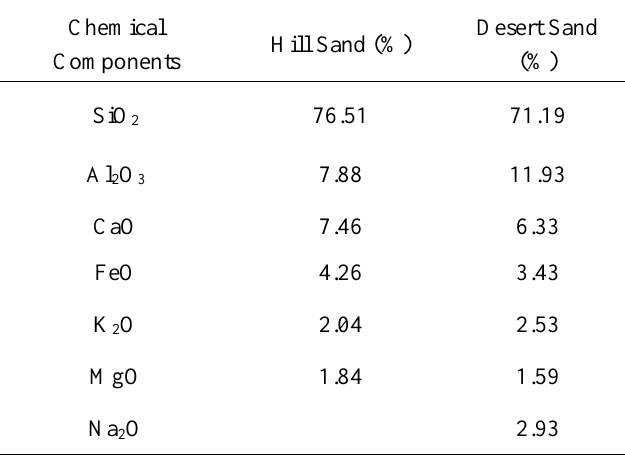
Chemical composition of Hill and Desert sand Chemical